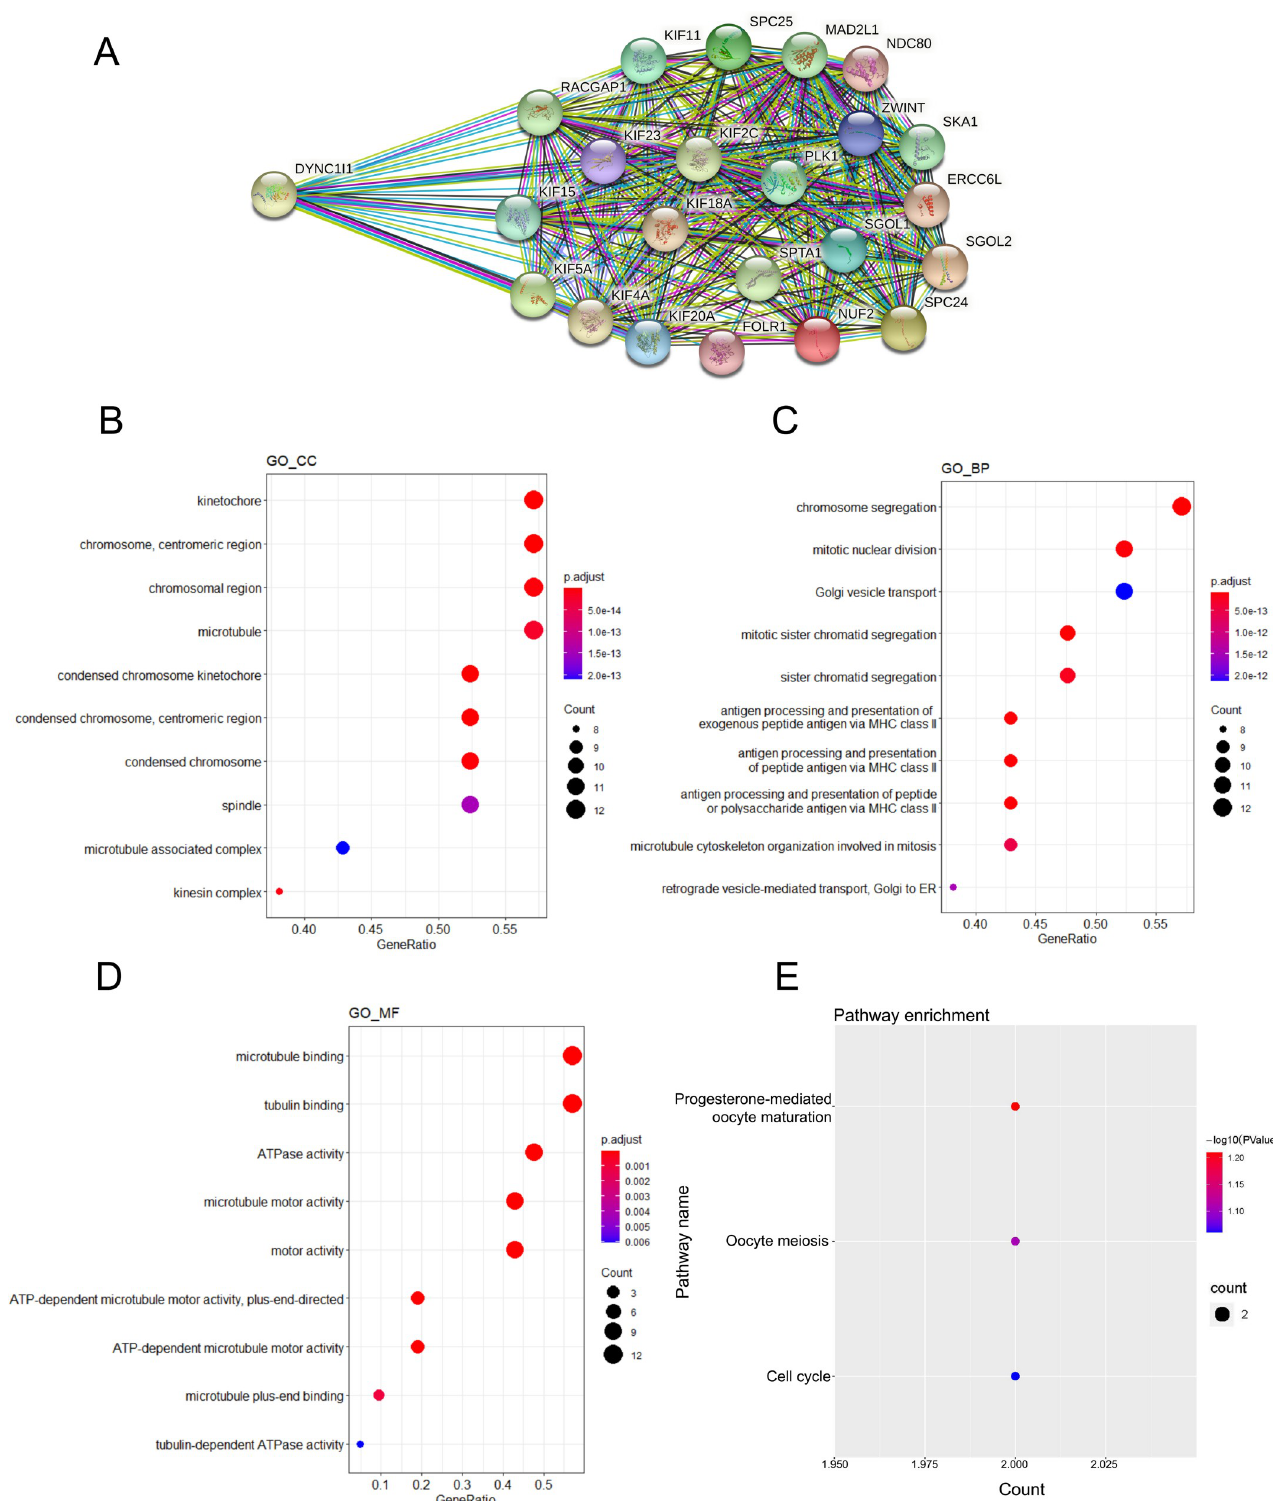
Fig 5. Function analysis of DYNC1I1. The figure showed the cellular component (A), biological process (B) and molecular function (C) of DYNC1I1 and the proteins that interacted with it (D); E. Possible pathways mediated by DYNC1I1 and its interacting proteins. The color of the dot represents the P value, and the size of the dot represented the number of